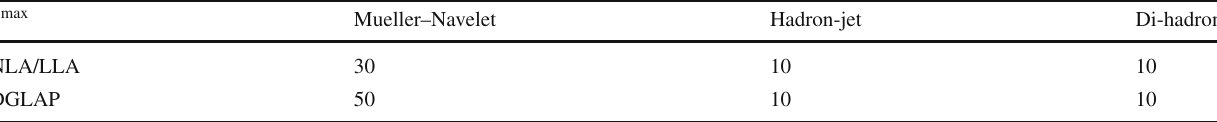
Table 1 Values of the upper cutoff, ν max , on the numerical ν -integration of the C n coefficients in the NLA/LLA BFKL accuracy ((Eqs. (7) and (8)) and in the high-energy DGLAP limit (Eq. (17)), for all considered reactions (Fig.